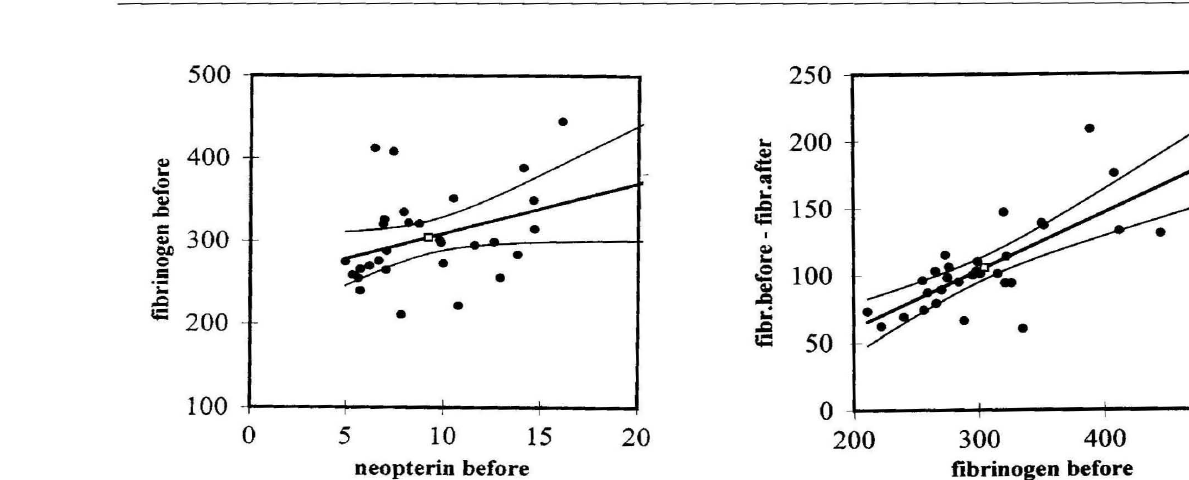
Figure 1. Linear correlation and regression analysis of neopterin in serum before H.E.L.P versus fibrinogen in serum before H.E.L.P. (bold straight line: regression line; hyperbolic lines: 95 percent confidence limits of the regression line; r= +0.38, p=0.04)